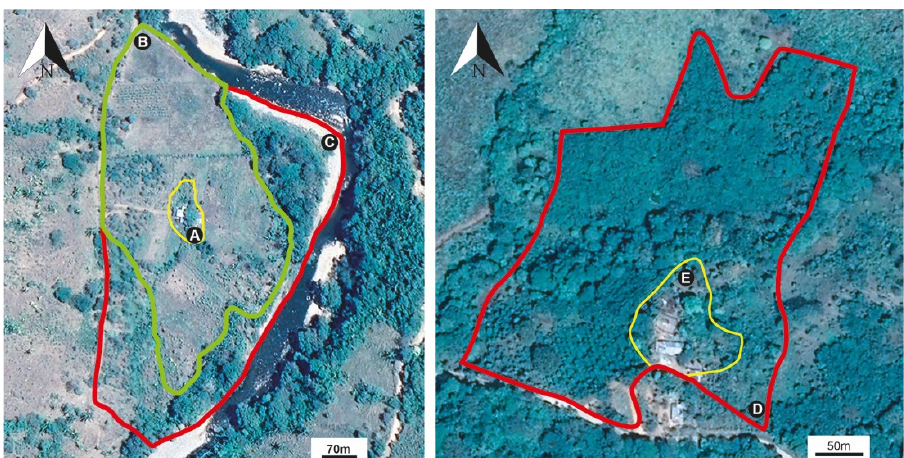
Figure 4. Examples of the layouts of FF plots in the municipality of Buenos Aires. On the left, peasant management; ( A ) First perimeter with the house and orchard; ( B ) Second perimeter with the coffee and basic grain crops under different management systems; ( C ) Third perimeter with conserved forest. On the right, the indigenous polyculture management; ( D ) First perimeter with the house and orchard; ( E ) Second perimeter with the crops integrated within the forest. Source: generated by the authors from Google Earth/Image © 2021 CNES/Airbus images .